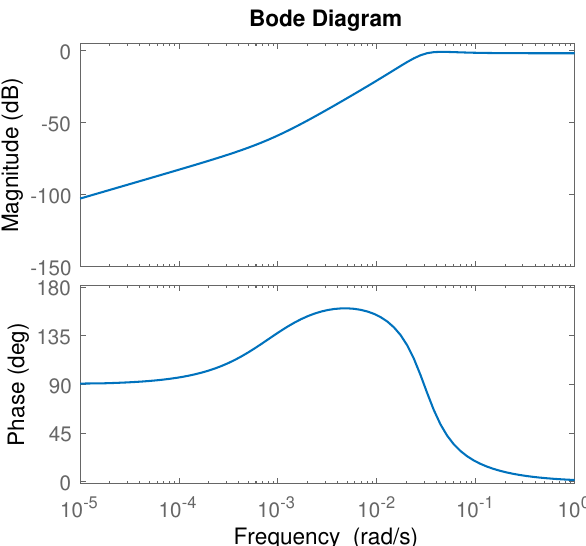
Figure 11. Bode diagram of W (cid:101) S for K p = 3.2 and K i = 0.16 considering multiplicative feedback uncertainty.